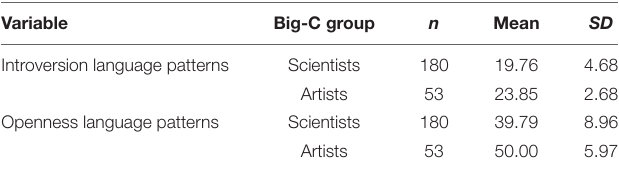
Variable Big-C group n Mean